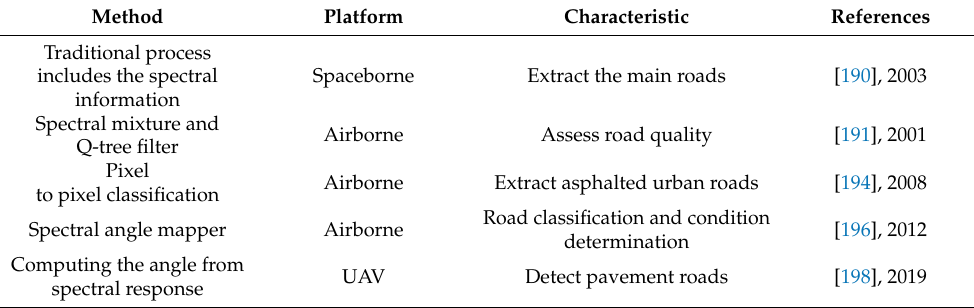
Table 5. Summary of road extraction using hyperspectral